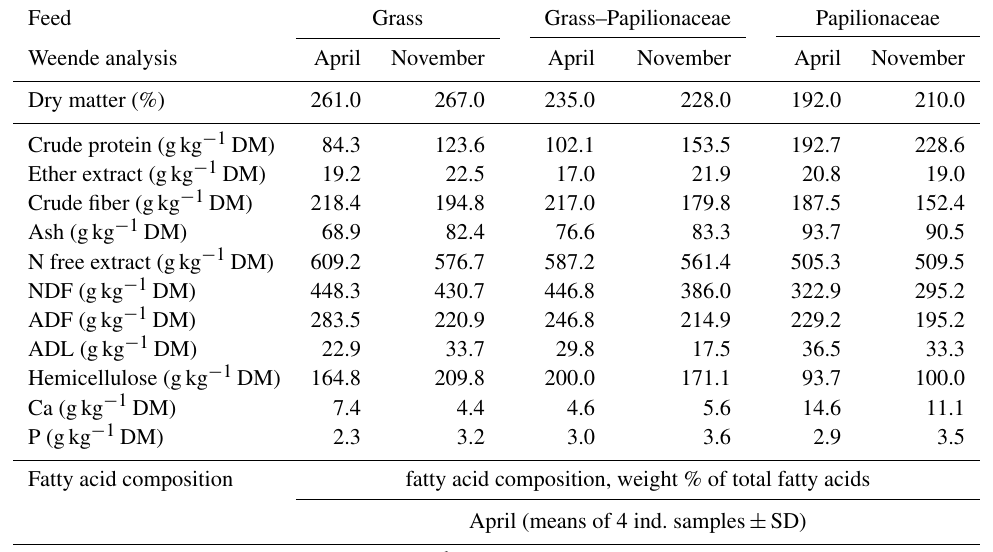
Table 2. The chemical and the fatty acid composition of the pastures. Feed Grass